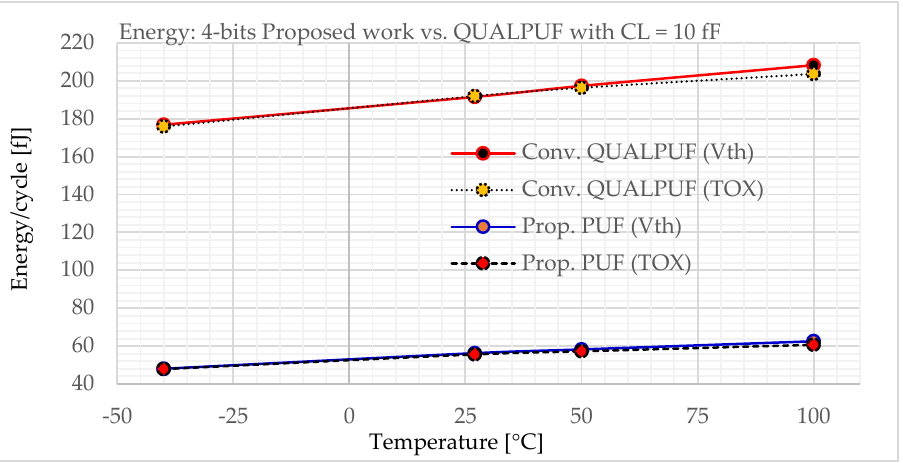
Figure 9. 4-bits PUF energy dissipation of the proposed adiabatic PUF versus QUALPUF under CMOS process variation.